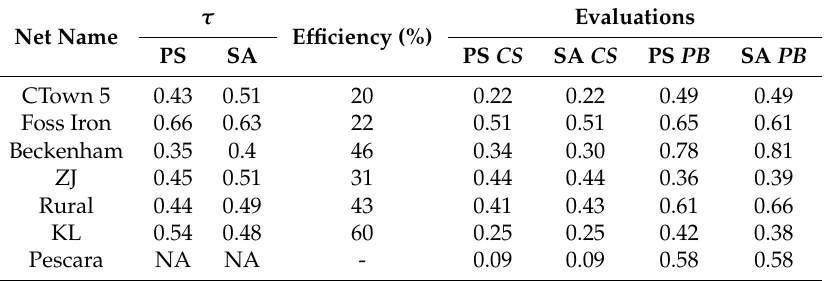
Table 3. Efficiency comparison of parameter sweeping (PS) vs. randomized τ selection (R τ S)